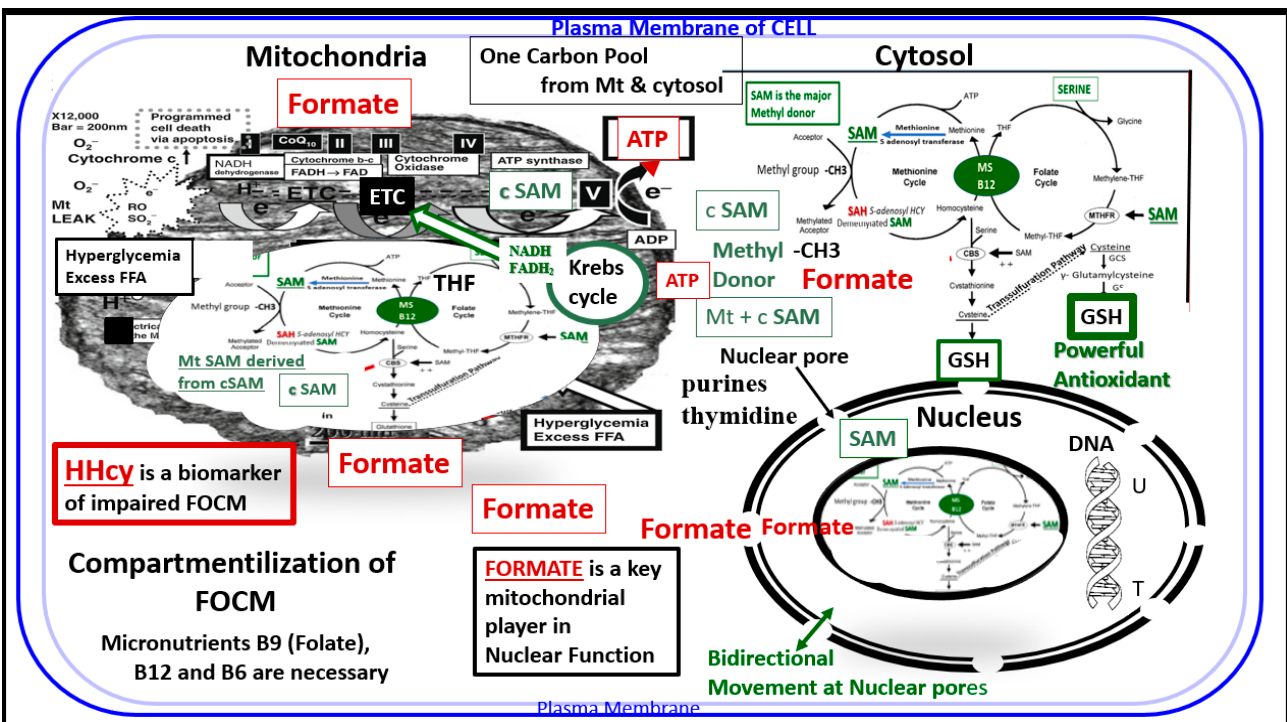
Figure 2. Compartmentalization of FOCM. Note the presence of the folate-methionine one carbon cycle metabolism in the cytoplasm (cytosol), mitochondria and nucleus. Additionally, note the importance of formate being transferred from the mitochondria to the nucleus, as well as S - adenosylmethionine (SAM) via nuclear pores. Importantly, deoxythymidine monophosphate (dTMP) synthesis occurs in the cytosol, nucleus and mitochondria, whereas purine synthesis and methionine synthesis take place within the cytosol. Mitochondrial FOCM generates formate for cytosolic and nuclear FOCM and biosynthetic precursors for mtDNA synthesis and mitochondrial protein trans- lation. Thymidylate synthase (TYMS) converts deoxyuridine monophosphate (dUMP) to dTMP in a 5,10-methylene-THF-dependent reaction (not shown). It is important to note that mitochondrial SAM (Mt SAM) is derived from cytosolic SAM (cSAM). Additionally, the Krebs cycle also resides within the mitochondria and provides NADH and FADH2 to the electron transport chain for ATP production. ATP = adenosine triphosphate; c = cytosol; ETC = electron transport chain; FAD = flavin adenine dinucleotide; FADH = reduced flavin adenine dinucleotide; FFA = free fatty acids; HHcy = hyperhomocysteine- mia; MS = methionine synthase; Mt = mitochondria; NADH = reduced nicotinamide adenine dinucleotide; T = thymidylate-thymine; U = uracil